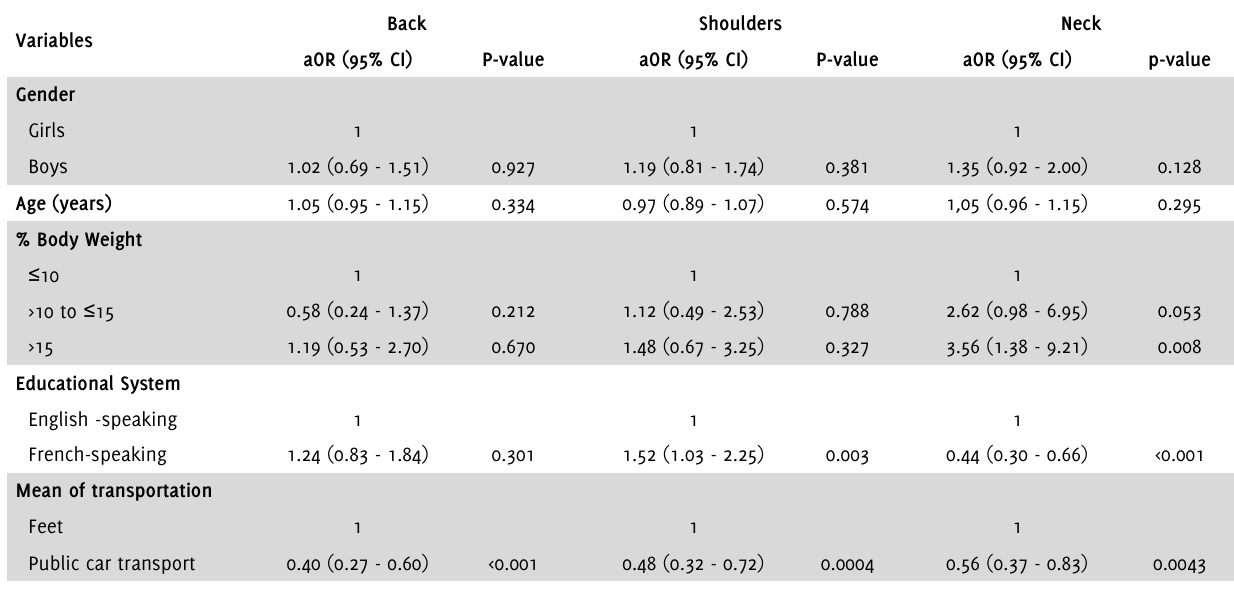
Table 4 . Risk factors for musculoskeletal symptoms in the back, neck and shoulders.